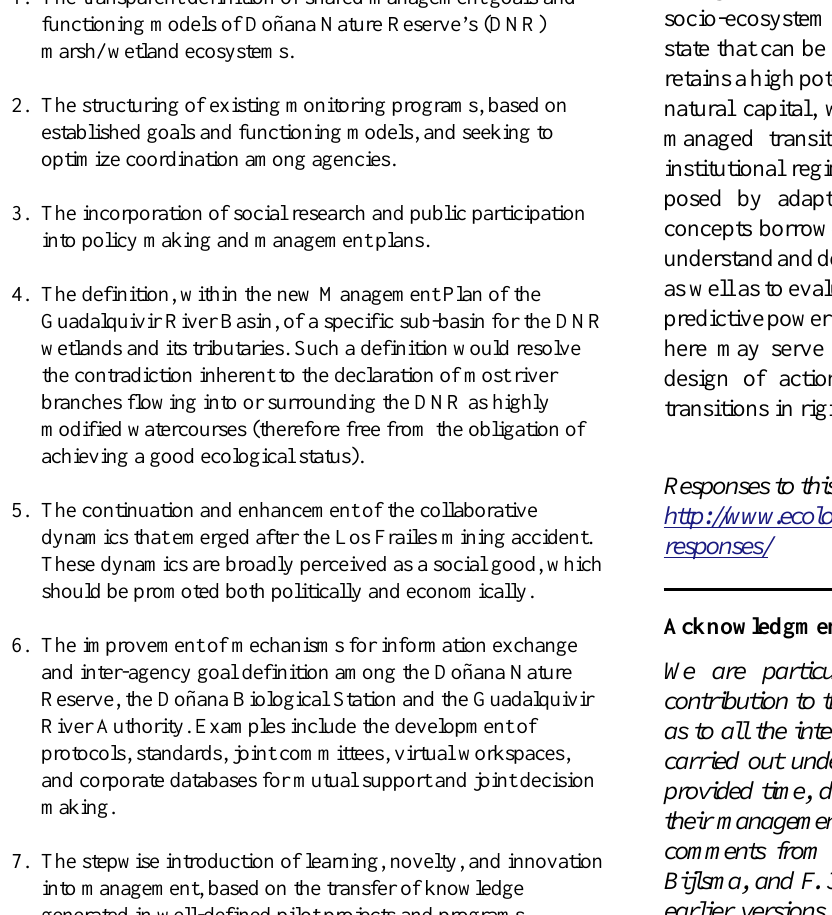
Table 4 . Shared list of recommendations to foster